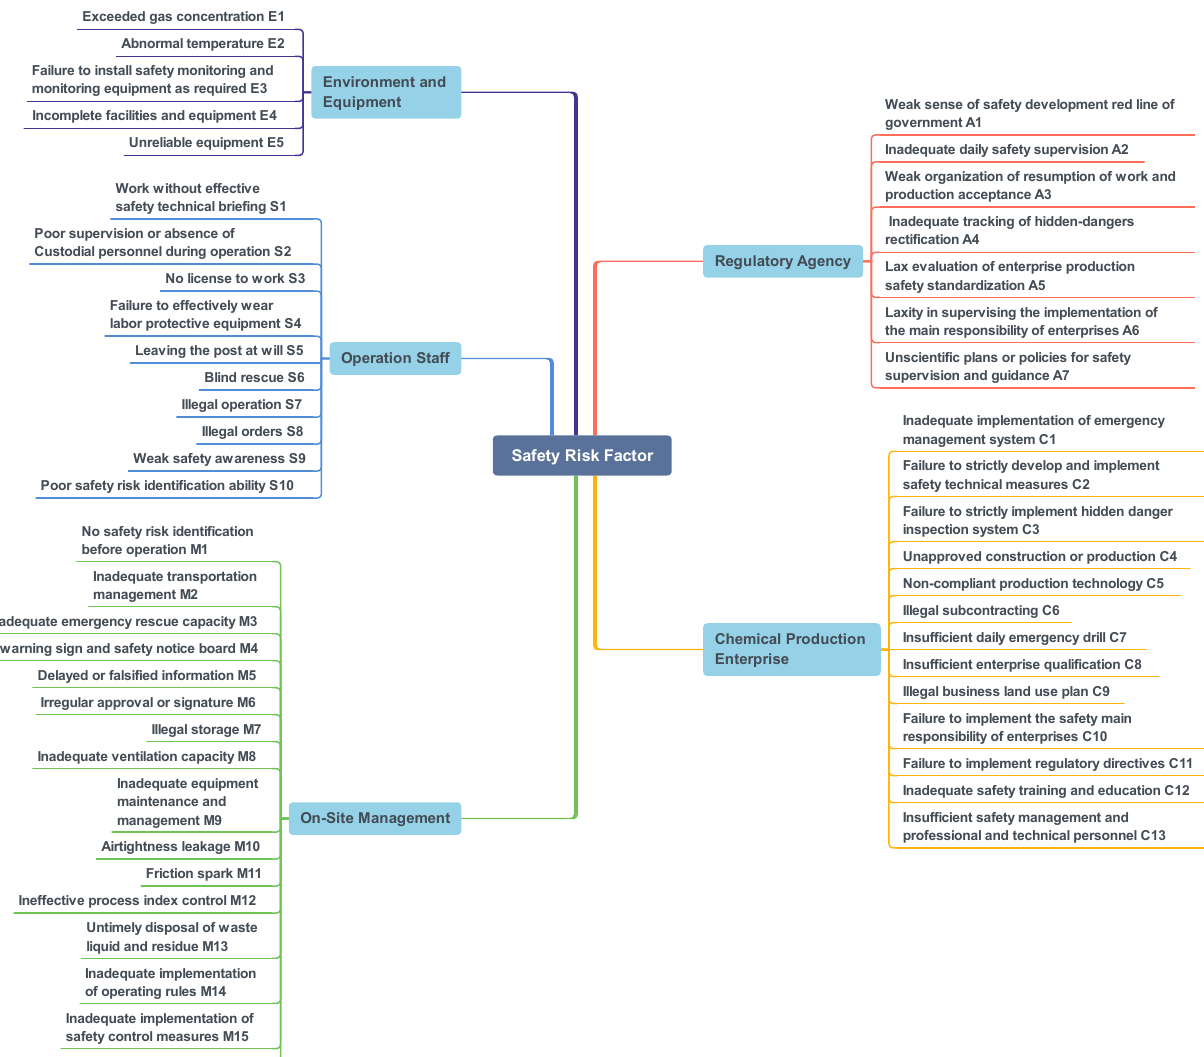
Figure 10. Chemical production safety risk